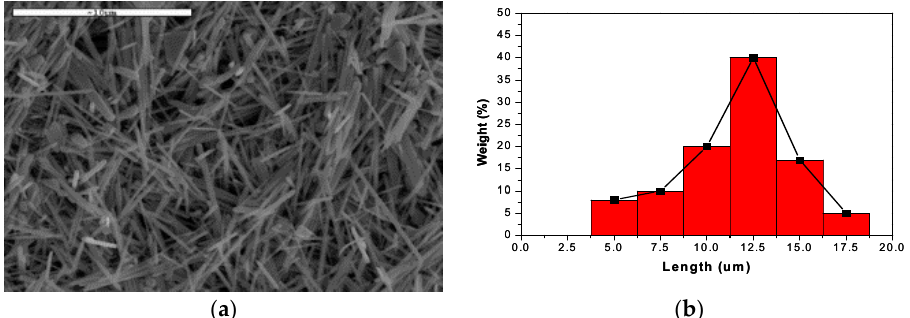
Figure 2. Purified silver nanowires (AgNWs): ( a ) scanning electron microscopy image; ( b ) length distribution of a purified AgNW.